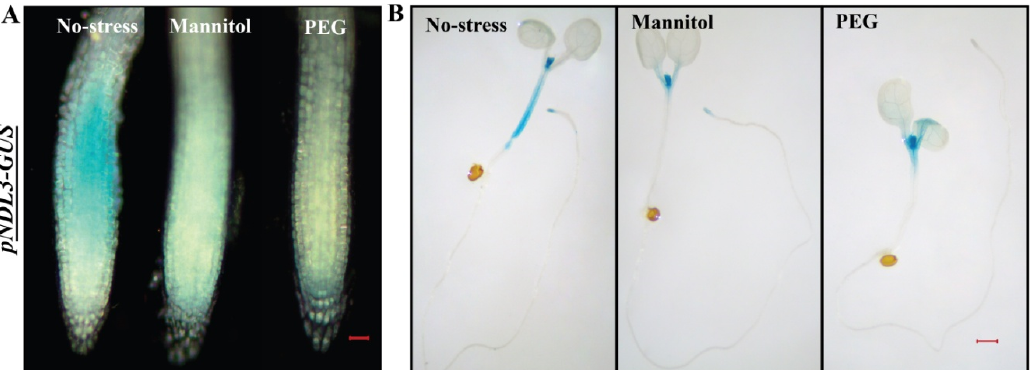
Figure 7. In vivo histochemical analysis of GUS activity for NDL3 in wild type Col-0 background in response to different abiotic stresses and hormones: ( A ). Histochemical GUS staining of 6-D-old transgenic Arabidopsis seedlings ( pNDL3-GUS) in wild type Col-0 background. Changes in intensity of GUS staining detected with PEG and Mannitol in RAM. ( B ) and in hypocotyl part of the seedlings. Result shown is representative of three independent biological replicates ( n ≥ 10 in each experiment). Scale Bar = 0.2 µ M for seedlings and 0.02 µ M for